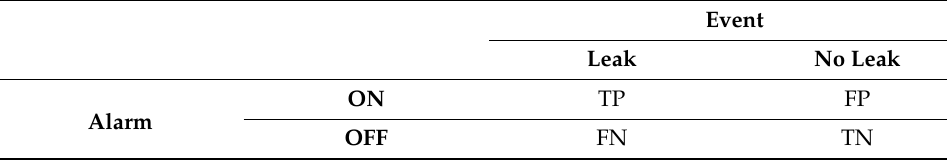
Table 3. Leak detection confusion matrix.